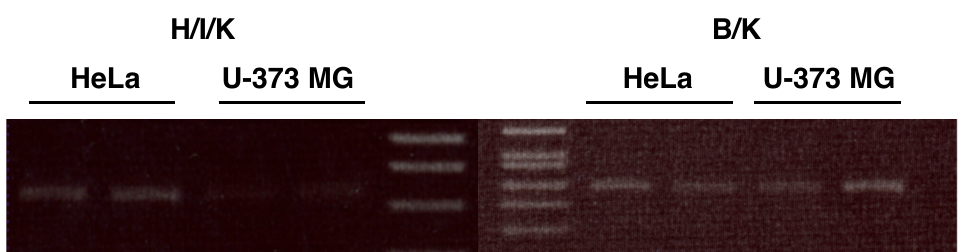
Figure 5. Expression of H/I/K and B/K splice variants in U-373 MG cells and HeLa cells. After starvation in serum-free medium for 24 h, total RNA was isolated. Total RNA (2 µ g) was reverse- transcribed to cDNA in the reaction mixture of 20 µ L. Three µ L of aliquot was used for the endpoint- PCR analysis by using splice variant-specific primers shown in Materials and